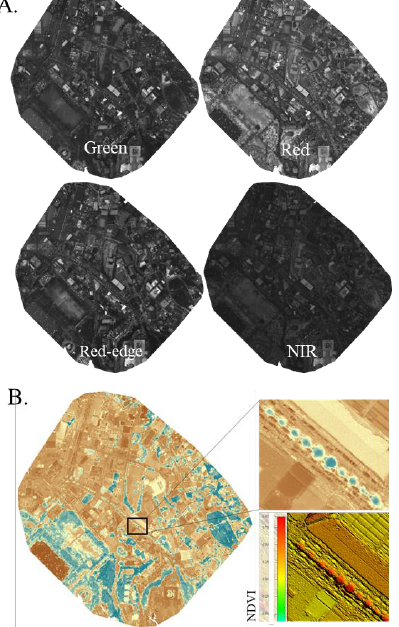
Figure 3. Multispectral bands (green, red, red-edge, and NIR) obtained using Sequoia multispectral camera mounted in Sensefly eBee drone (A). The red and NIR bands were used in generating high resolution NDVI map (B) which aided in isolating individual tree canopies (B, left) in addition to